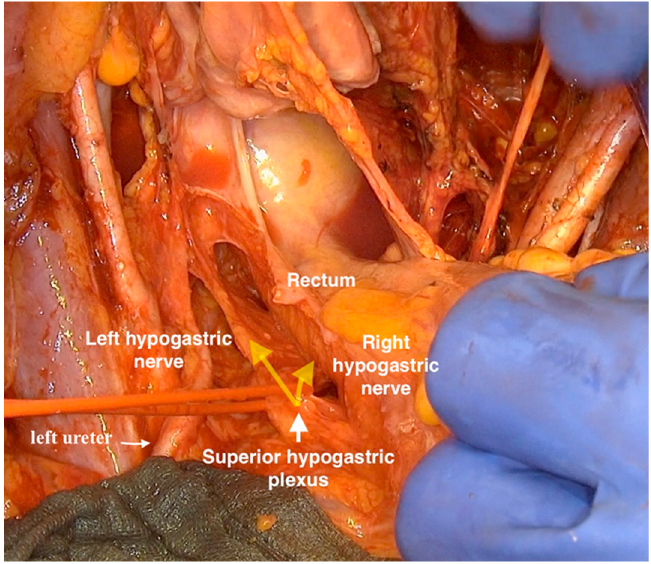
Figure 2. Highlighting the hypogastric nerves and superior hypogastric plexus.